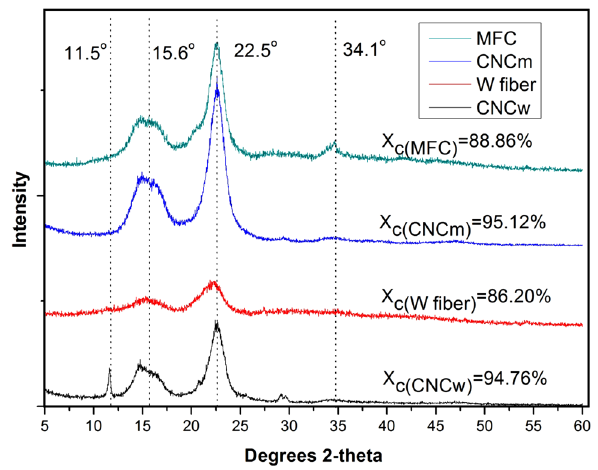
Fig. 2 XRD patterns of the water hyacinth fibers (W fiber), the microfibrillated cellulose (MFC), the W-based cellulose nanocrystals (CNC w ), and the MFC-based cellulose nanocrystals (CNC m )